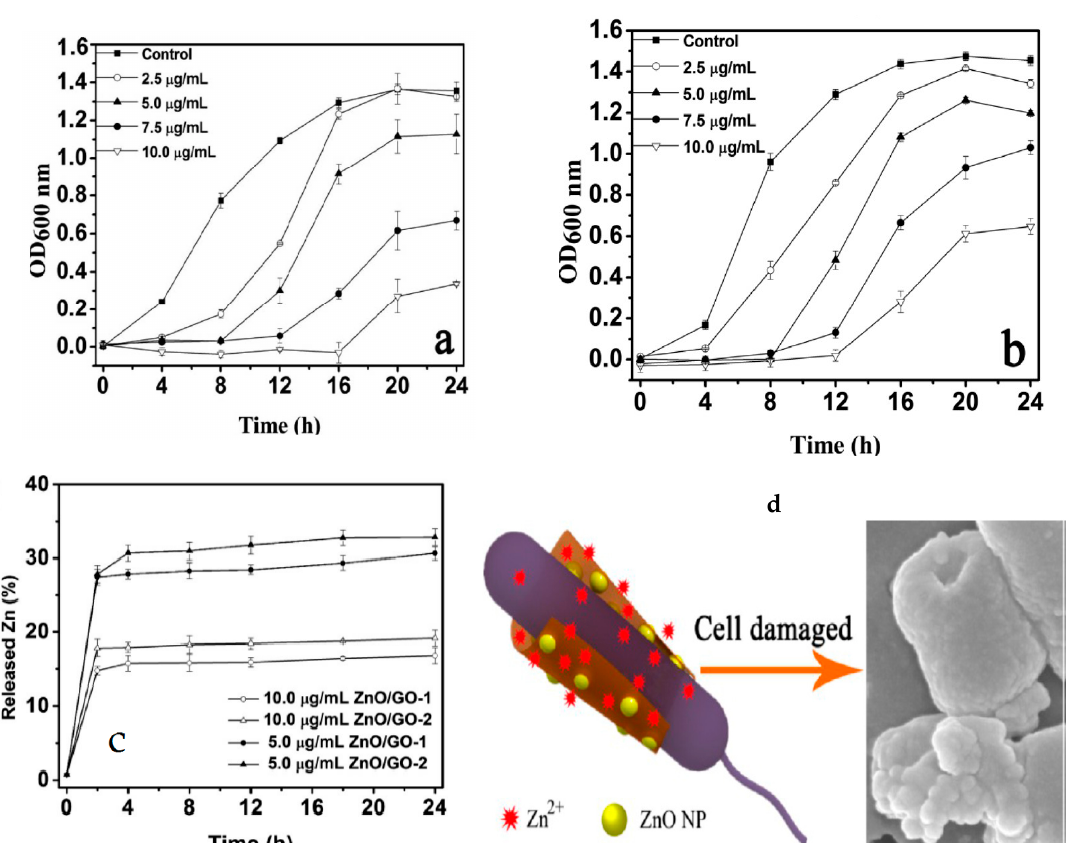
Figure 33. Growth curves of E. coli treated with ( a ) GO-1/ZnO and ( b ) GO-2/ZnO hybrids of different doses; ( c ) Zinc released from GO/ZnO composites; ( d ) Wrapping of graphene sheet around E. coli and released Zn 2+ ions led to bacterial cell membrane damage. The experiments were performed in triplicates, and the results were given as mean ± standard deviation. Reproduced from [242] with permission of the American Chemical Society.